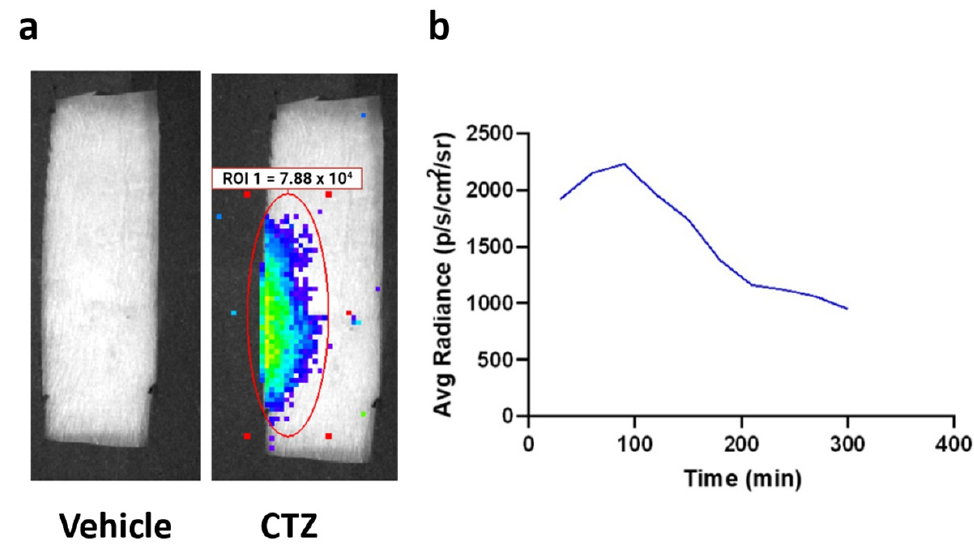
Figure 3. Bioluminescence emission from LMO3.2 expressing rats treated with either vehicle or CTZ. ( a ) In vivo bioluminescent imaging reveals luminescence concentrated over the lumbar spinal cord. Peak luminescence can be seen in the pseudo-colored yellow/green region directly over the spinal cord. ( b ) Average luminescence in the region of interest over the spinal cord. Radiance peaked between 60 and 120 min before slowly dissipating.